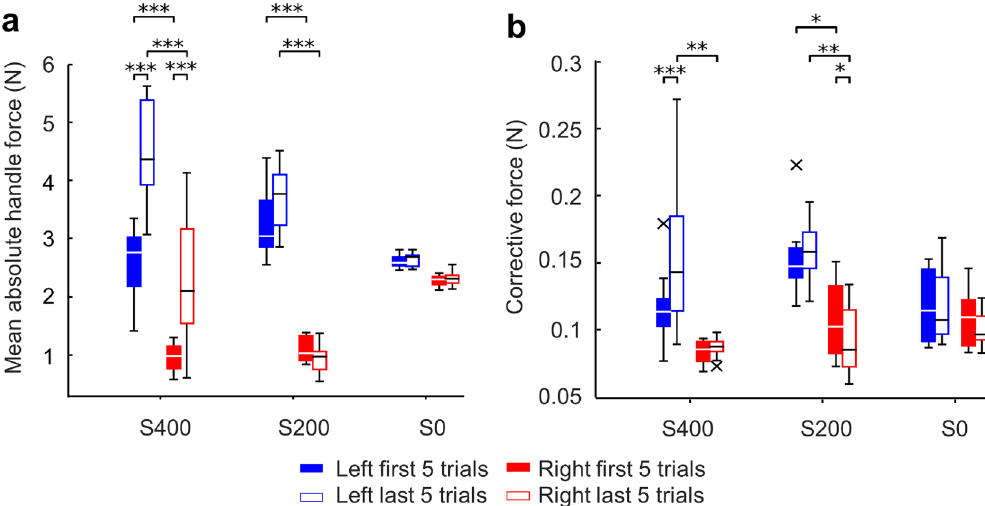
Figure 4. Changes of measured handle forces . ( a ) Comparison of mean absolute handle force between first and last five successful trials. ( b ) Comparison of corrective force between first and last five successful trials. Asterisks denote statistically significant differences between conditions (*, ** and *** denote p < 0.05, 0.01 and 0.001, respectively). Data shown in each panel are from 48 subjects (24 dyads; 8 dyads per experimental condition). Vertical bars denote 1.5 interquartile range. The ‘×’ symbols in the whisker plot denote outliers beyond